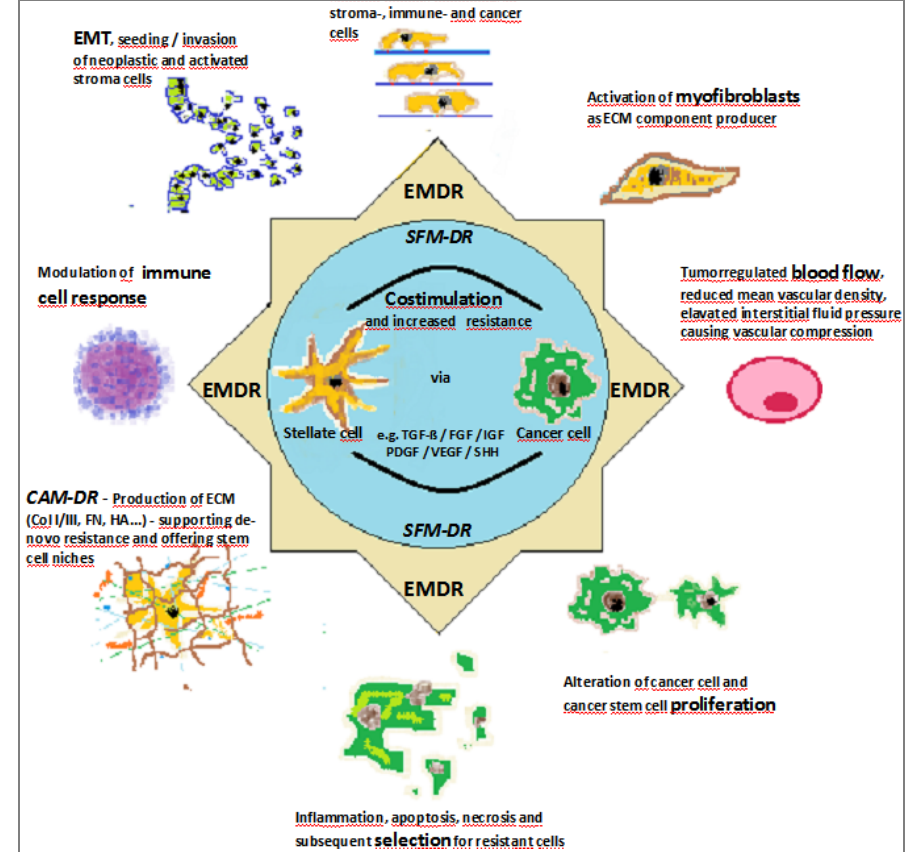
Figure 1. Octagon of environmental mediated drug resistance (EMDR) in pancreatic cancer. Soluble factor mediated drug resistance (SFM-DR), a form of EMDR (yellow), is shown in